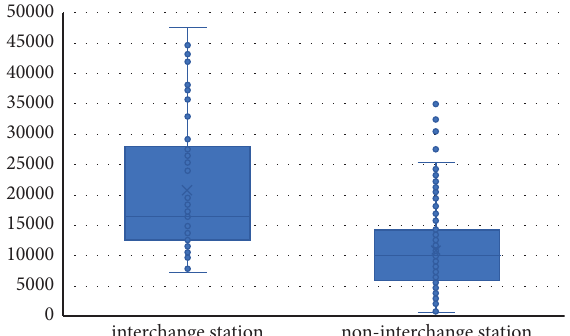
Figure 6: Comparison of average daily passenger fow between interchange stations and noninterchange stations.